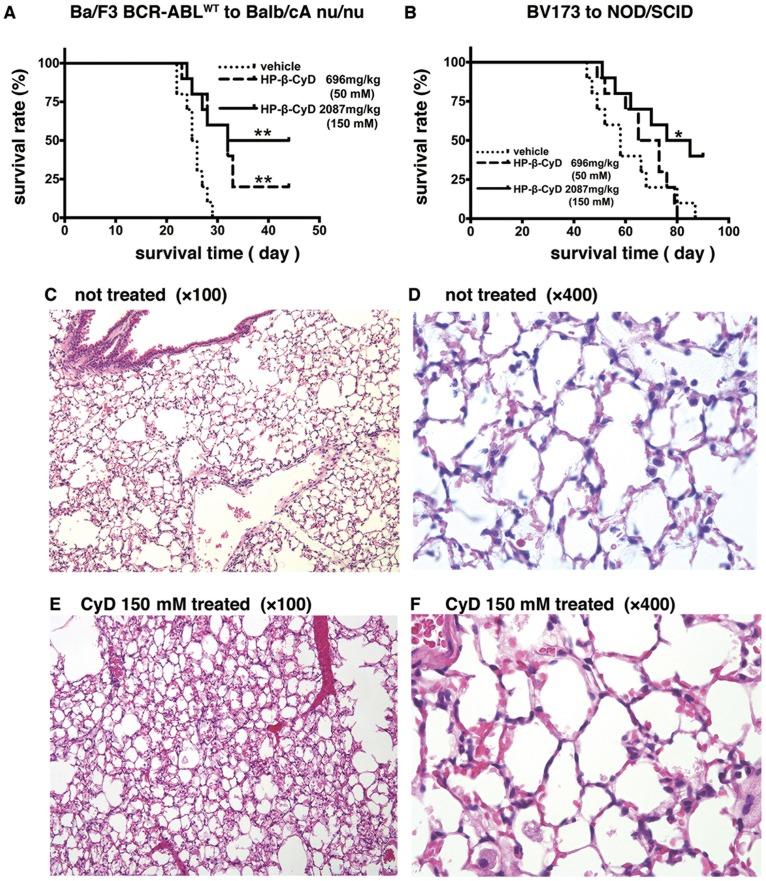
Effect of HP-β-CyD on survival in leukemia mouse models.(A) Survival of mice that received EGFP+ Ba/F3 BCR-ABLWT cells. EGFP+ Ba/F3 BCR-ABLWT cells (1×106) were transplanted into 6-week-old nude mice. Three days after transplantation, 200 μL vehicle, 50 mM (695.5 mg/kg) HP-β-CyD, or 150 mM (2086.5 mg/kg) HP-β-CyD were intraperitoneally injected twice a day for 20 days, and survival was monitored daily. Gray lines, dotted lines, and black lines indicate the survival curves of vehicle-, 50 mM HP-β-CyD- and 150 mM HP-β-CyD-treated mice, respectively. Survival data were analyzed using a log-rank nonparametric test and are shown as Kaplan-Meier survival curves (n = 10). **P < 0.01. (B) Survival of human leukemia xenografted mice transplanted with BV173 cells. BV173 cells (1×106) were intravenously injected into 2 Gy irradiated NOD/SCID mice. Three days after transplantation, 200 μL vehicle, 50 mM HP-β-CyD (695.5 mg/kg HP-β-CyD), or 150 mM HP-β-CyD (2086.5 mg/kg HP-β-CyD) were administered intraperitoneally for 5 consecutive days every week for 13 weeks, and survival was monitored daily. Gray lines, dotted lines and black lines indicate the survival curves of vehicle-, 50 mM HP-β-CyD-, and 150 mM HP-β-CyD-treated mice, respectively. Survival data were analyzed using a log-rank nonparametric test and are shown as Kaplan-Meier survival curves (n = 10). *P < 0.05. (C–F) Histological examination of lungs from age-matched controls, and HP-β-CyD-treated NOD/SCID mice. (C and D) hematoxylin and eosin (H&E) stained control lung. (C) Original magnification, ×100; (D), ×400. (E and F) H&E stained 150 mM HP-β-CyD-treated lung. (E) Original magnification, ×100; (F), ×400. Representative images from at least two samples are shown.